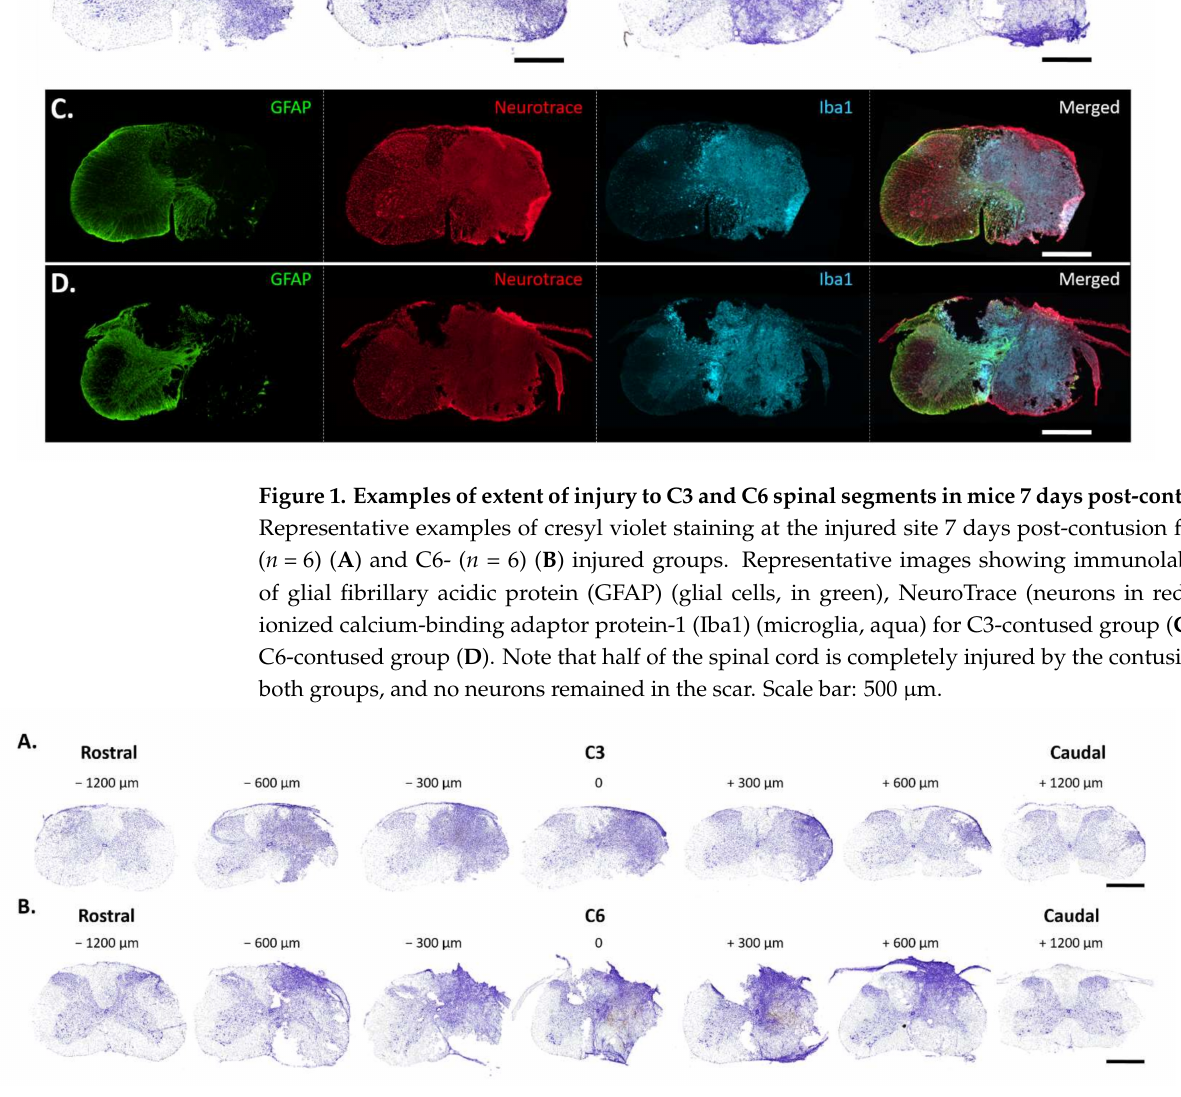
Figure 2. Representative rostro-caudal extent of contusion injury in C3- (A) and C6- (B) contused groups , where 0 represents the epicenter of the injury. Each picture is separated by 300 µ m width. Note that the injury extends more than 2000 µ m from the epicenter. Scale bar: 500 µ